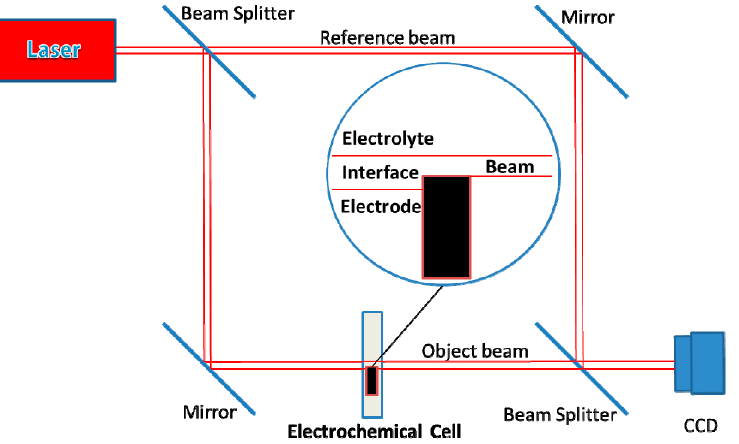
Figure 1. Schematic diagram of holographic setup for the observation of an electrode/electrolyte